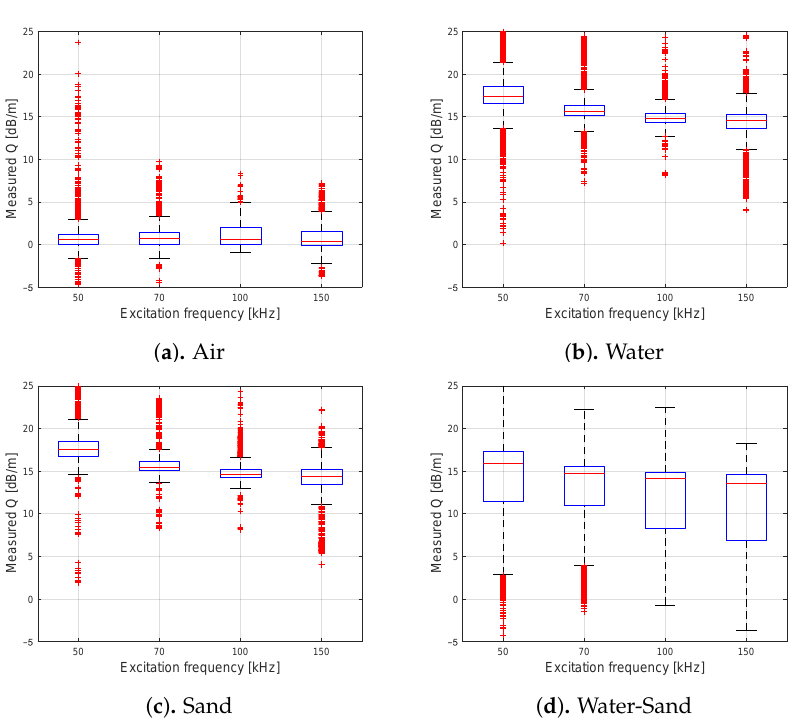
Figure 6. Estimated attenuation rates Q along each phase for the measured energy decays and the known travel distances. The data contains all measured circumferential FA-L(0,1) of ring number two and is specified for each excitation frequency separately. Additionally, the data is selected for propagation paths solely along the given phase (air, water or sand) or phase transition (water-sand).